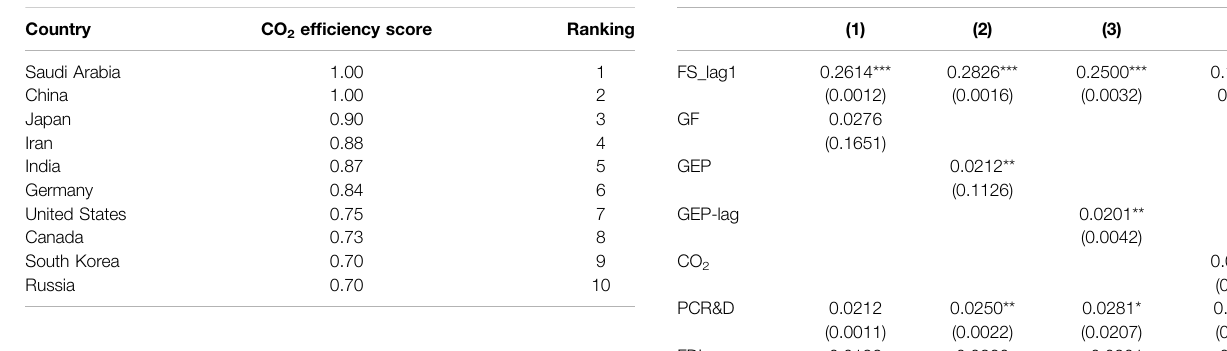
TABLE 9 | Estimation results of one- and two-step